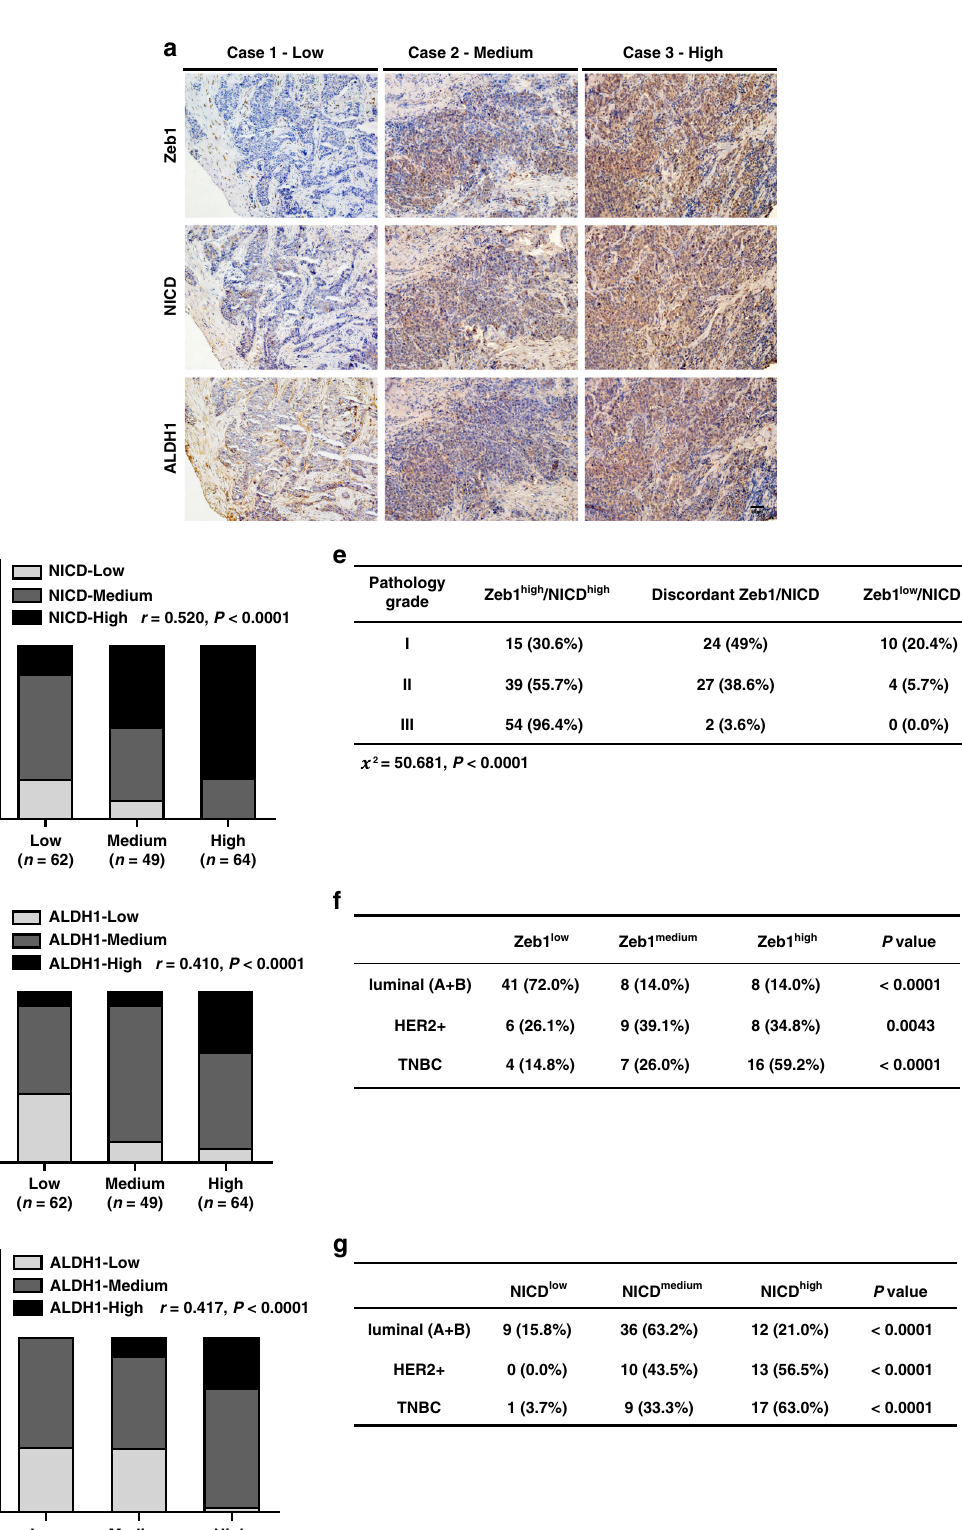
Fig. 7 Zeb1 expression is positively correlated with enhanced Notch1 activity in aggressive human breast cancer. a Representative images of immunohistochemical staining of Zeb1, NICD, and ALDH1 in serial sections of the same tumor ( n = 175). Scale bars, 50 μ m. b A positive correlation between the expression of Zeb1 and NICD in the 175 human breast cancer samples. c A positive correlation between the expression of Zeb1 and ALDH1 in breast cancer. d A positive correlation between the expression of NICD and ALDH1 in breast cancer. e Concomitantly high expression of Zeb1 and NICD in poorly differentiated high-grade breast cancer. f , g A strong correlation between high expression of Zeb1 ( f ) and NICD ( g ) in the TNBC subtype of breast cancer. Indicated P -values were calculated using Spearman ’ s rank correction test in b – d or Kruskal – Wallis test in e or Kolmogorov – Smirnov test in f , g . Source data are provided as a Source Data fi